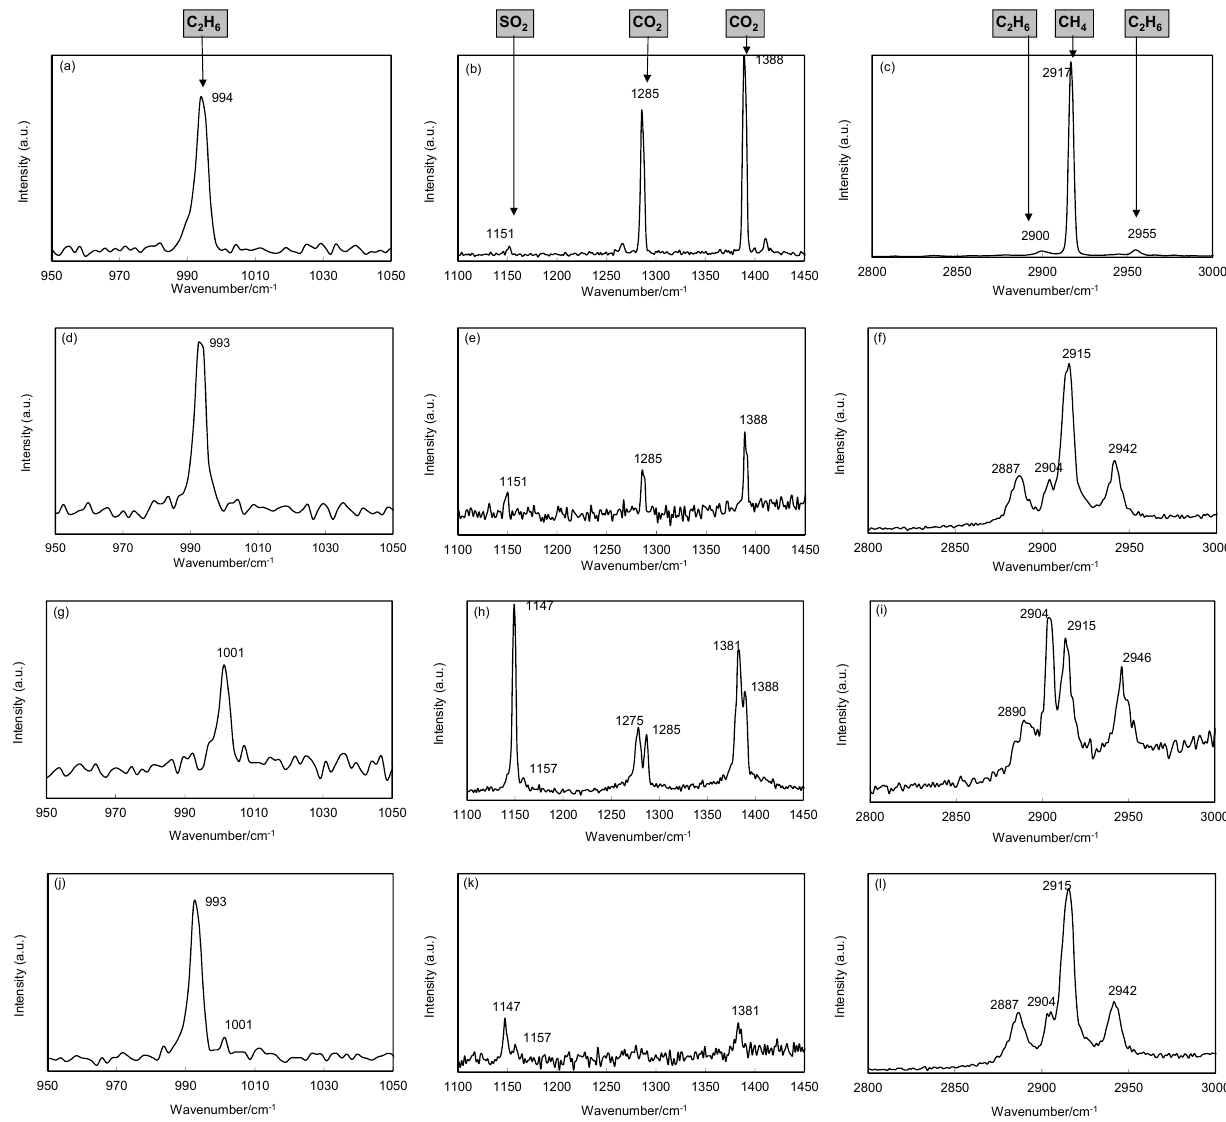
-C H against CO 4 2 6